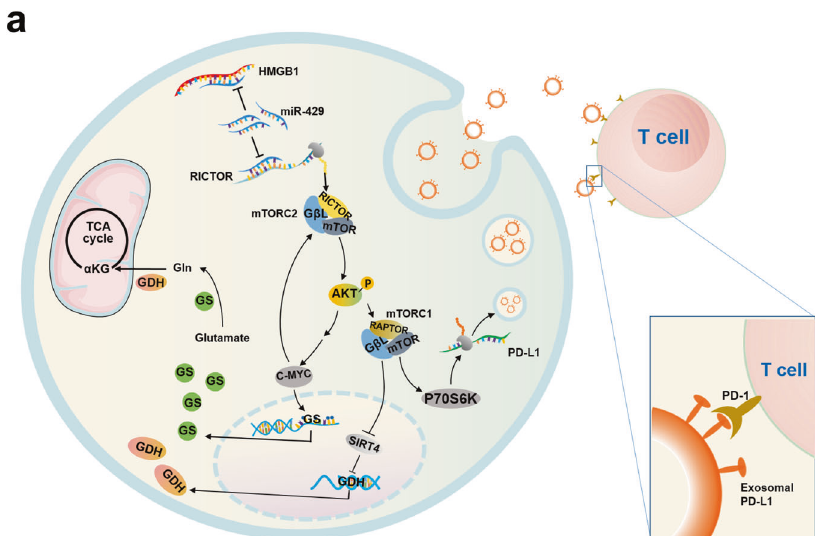
Fig. 7 Mechanism atlas. a A model of the RNA – RNA crosstalk network involving HMGB1 and RICTOR acting in the early stage